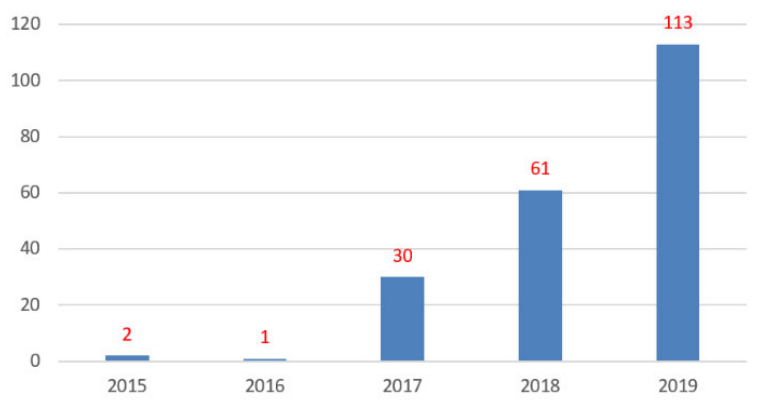
2 of 5 Figure 1. Number of submitted manuscripts (blue bars) and published papers (orange bars) in the Medicinal Chemistry section of Molecules in the period 2015–2019. 